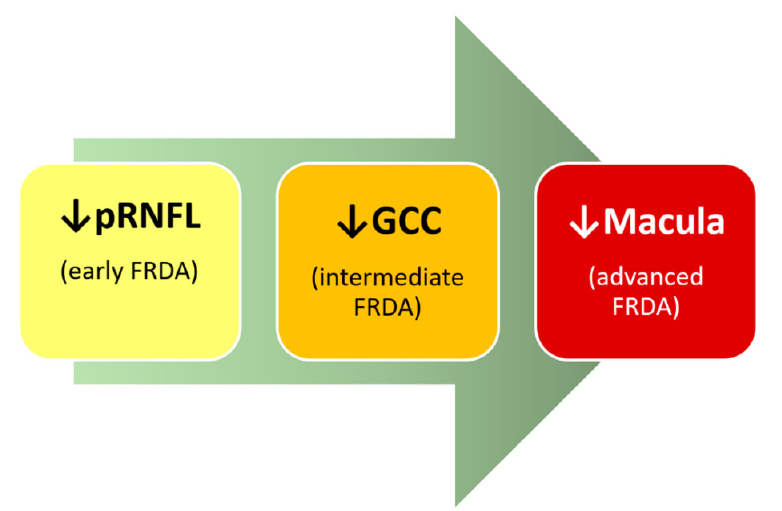
Figure 2. OCT and FRDA: summarize the sequential involvement. In the early onset of FRDA, there is an affectation of pRNFL; in the intermediate FRDA, there is a loss in the ganglion cell complex (GCC); and in advanced stages, there is a thinning in the macular